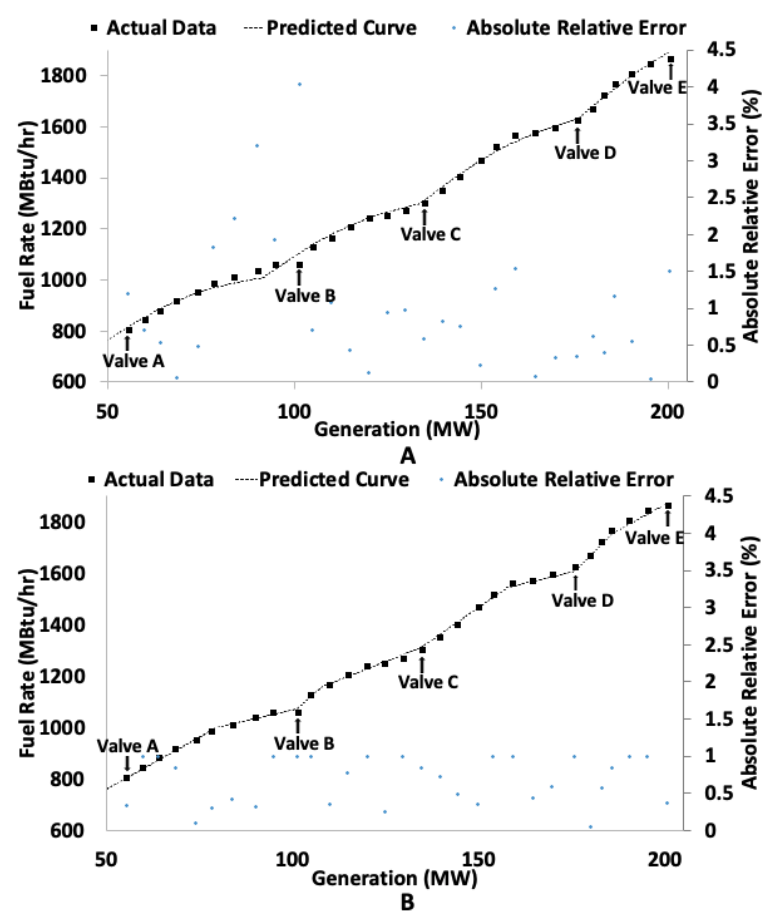
Figure 3. Actual input-output curve data versus predicted input-output curve using Equation (5) in A, and using a piecewise-linear function in